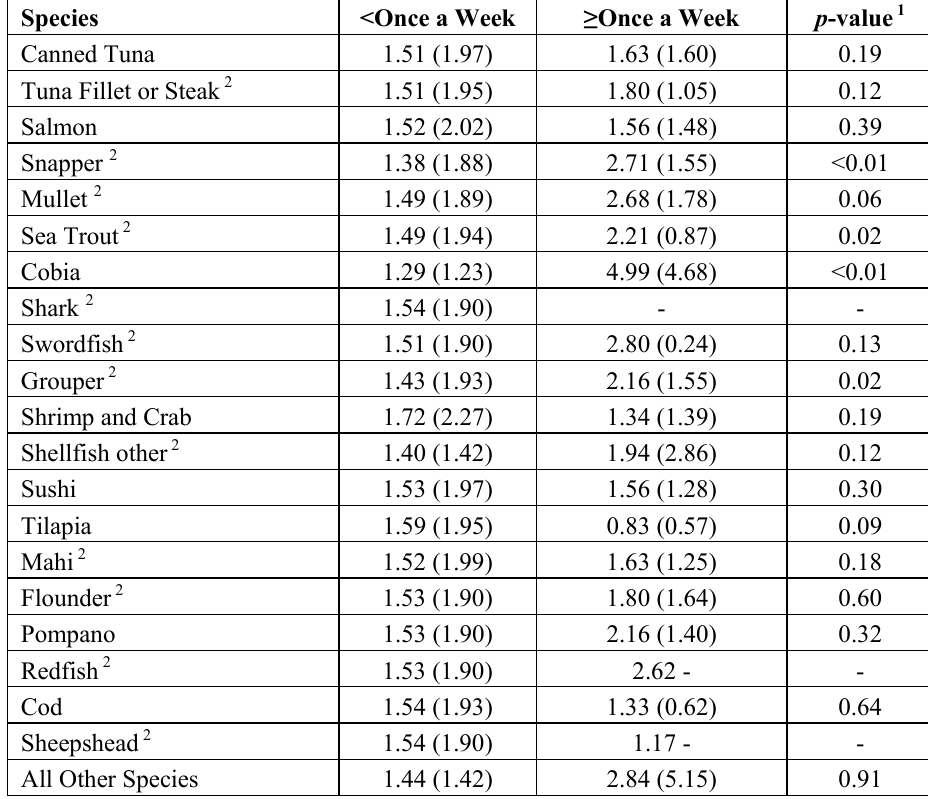
Table 2. Mean total hair mercury concentration (µg/g) by frequency of fish and shellfish consumption and species, Florida 2011–2012.